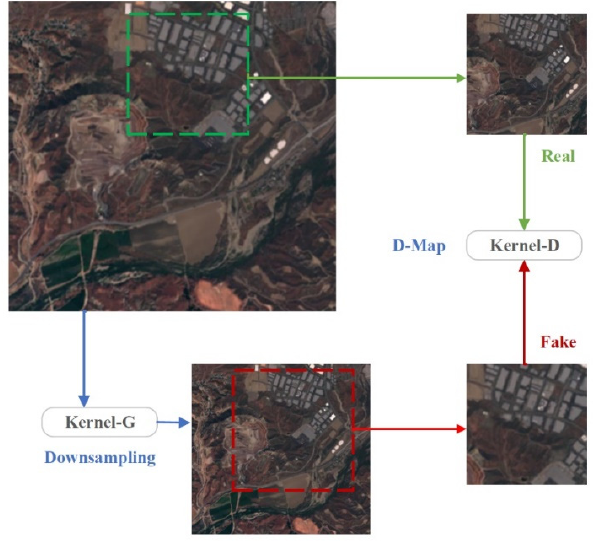
Figure 3. Structure of KernelGAN.